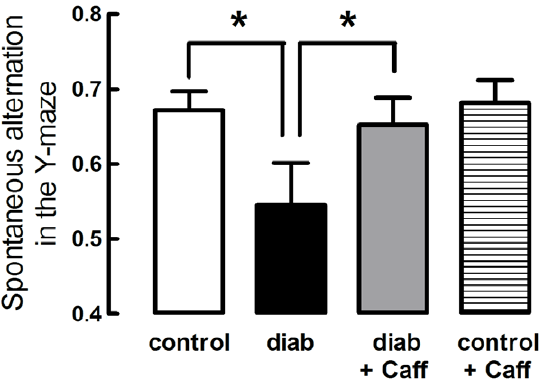
Figure 1 . Caffeine consumption prevents memory deficits induced by diabetes . Diabetic mice (black bars) had a reduced spontaneous alternation in the Y-maze at 11 months of age, when compared to controls (white bars), but not if treated with caffeine (grey bars) for 4 months (dark bars), whereas control mice consuming caffeine (striped bars) were similar to controls. In contrast, neither diabetes nor caffeine affected the number of crossings or rearing events in the open-field arena or the total number of entries in the Y-maze arms (not shown). Data are mean 6 SEM of n=9–10 mice in each experimental group. *P , 0.05 versus